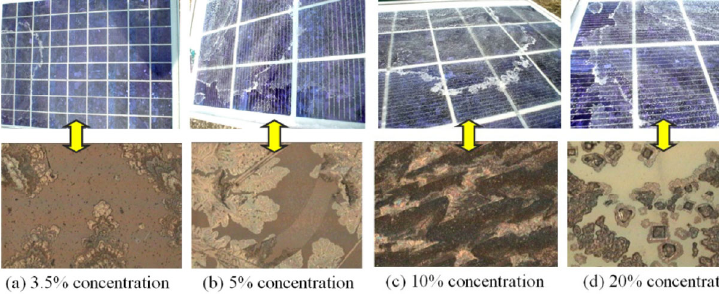
Fig. 8 Various types of solar ship.